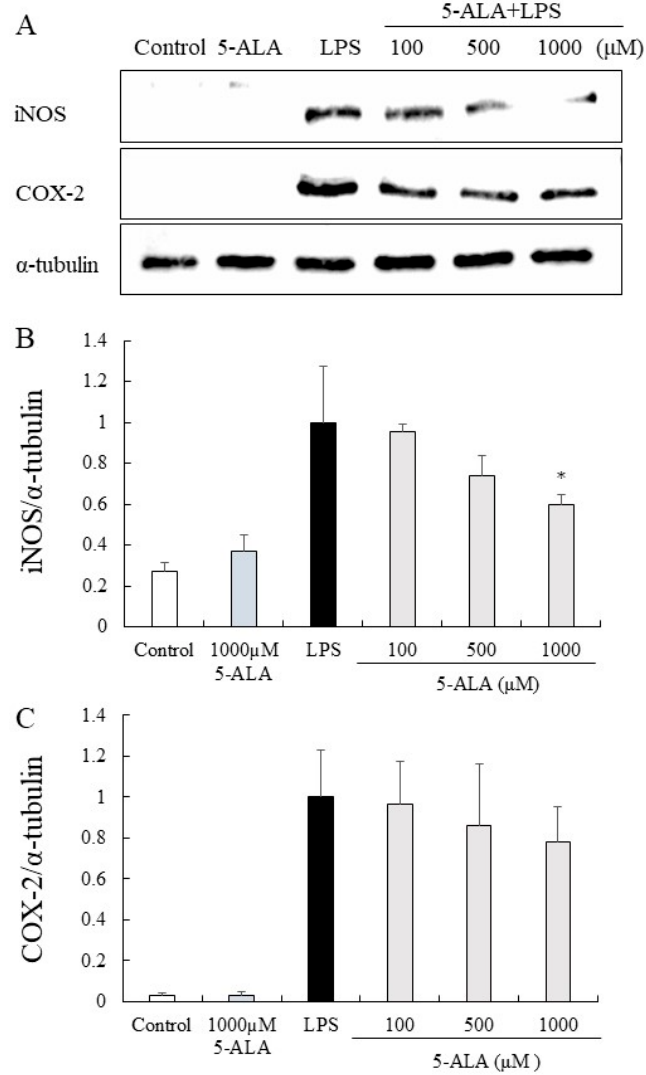
Figure 5. Inhibitory effects of 5-ALA on iNOS and COX-2 expression in LPS-stimulated RAW264.7 cells. With α -tubulin as a loading control, iNOS ( A , B ) and COX-2 ( A , C ) protein expression was detected by Western blot analysis. Cells were incubated with the indicated concentrations of 5-ALA and LPS for 24 h. Data represent the mean ± SD ( n = 3). * p < 0.05, compared with the LPS group. iNOS, inducible NO synthase (iNOS); COX-2, cyclooxygenase-2.